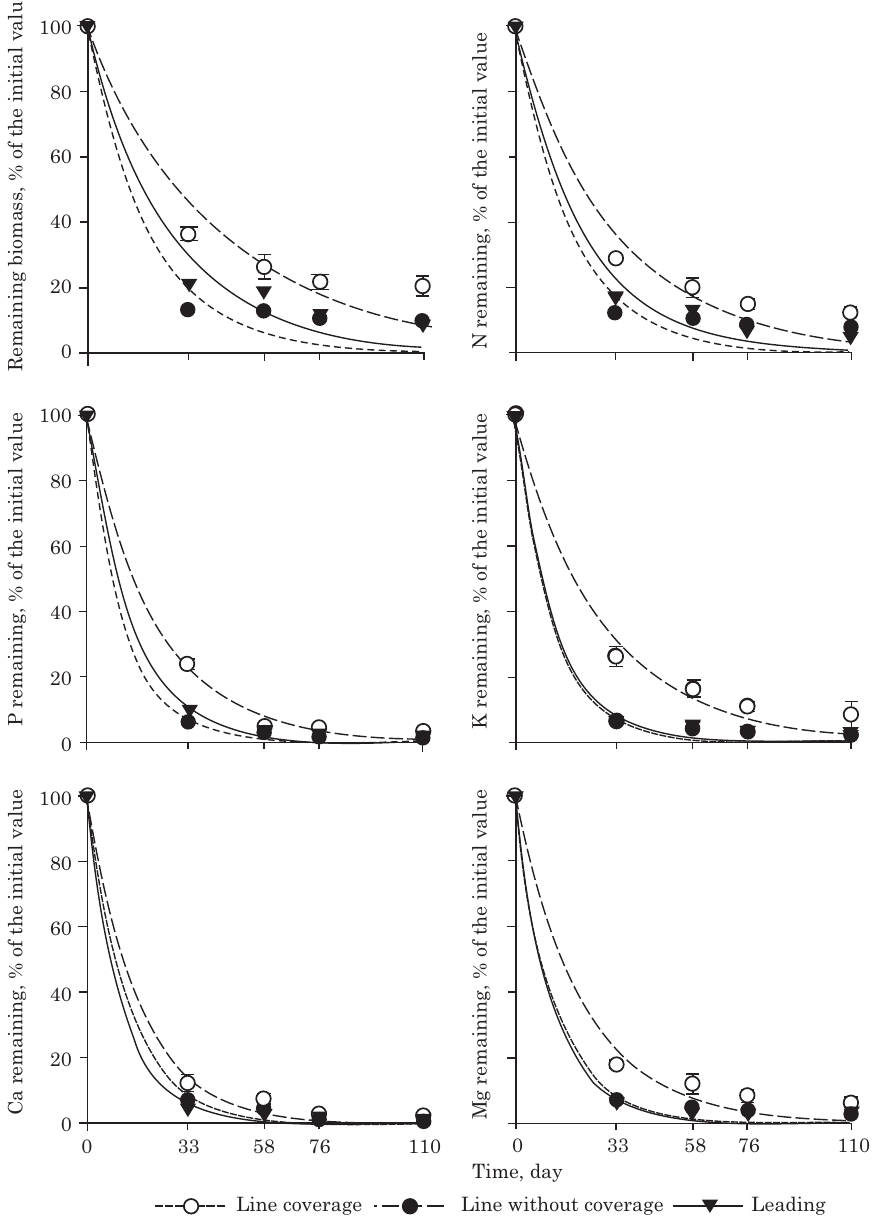
Figure 3. Remaining biomass, and N, P, K, Ca and Mg remaining from black oats in decomposition in the vine plant row without plastic shelter (VPRWS), in the vine plant row with plastic shelter (VPRS), and in the between-row area (BR). Values expressed as % of initial values. Vertical bars represent standard errors. The equations and significance of the adjustments are shown in table